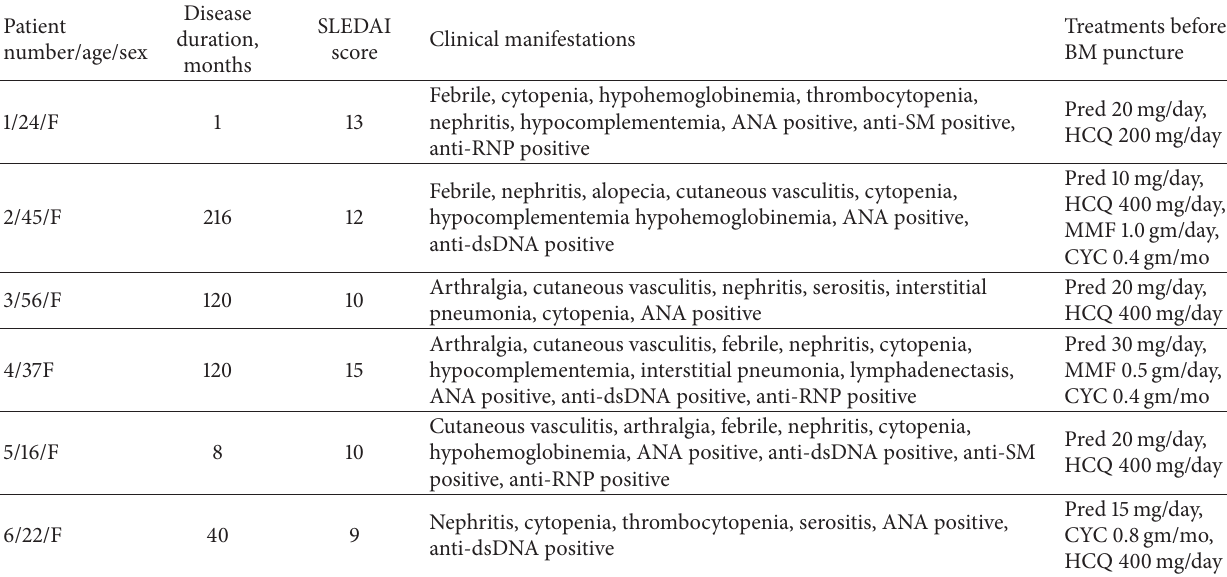
Table 1: Main clinical characteristics of SLE